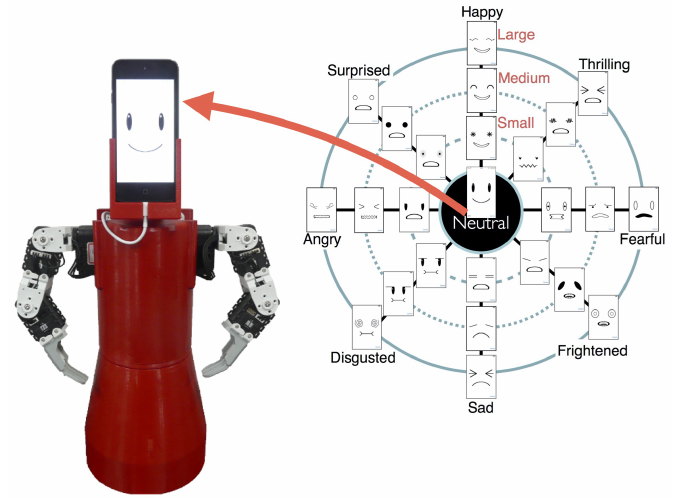
Figure 8. Facial expression of the robot